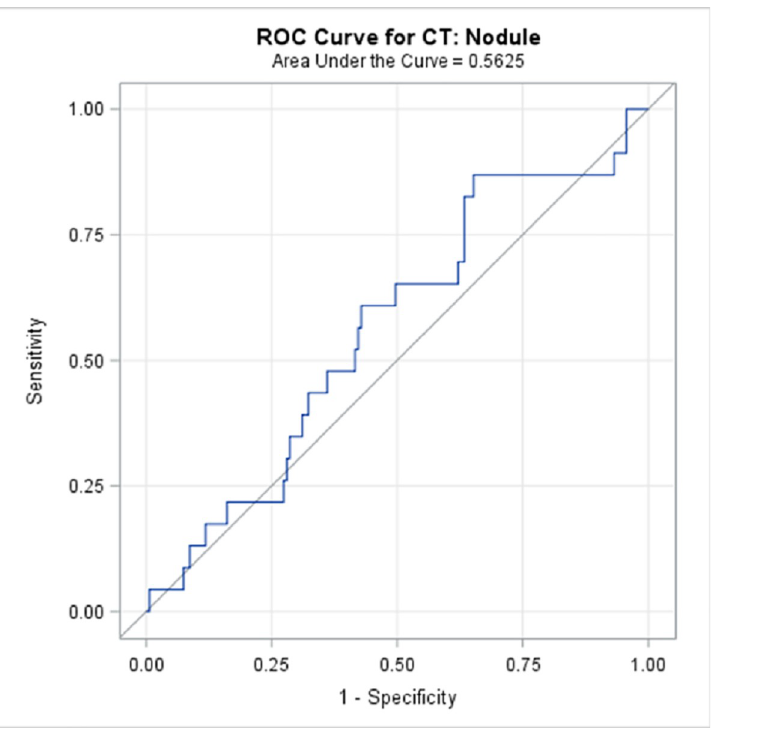
Fig 10. ROC Curve for CT: Nodule.